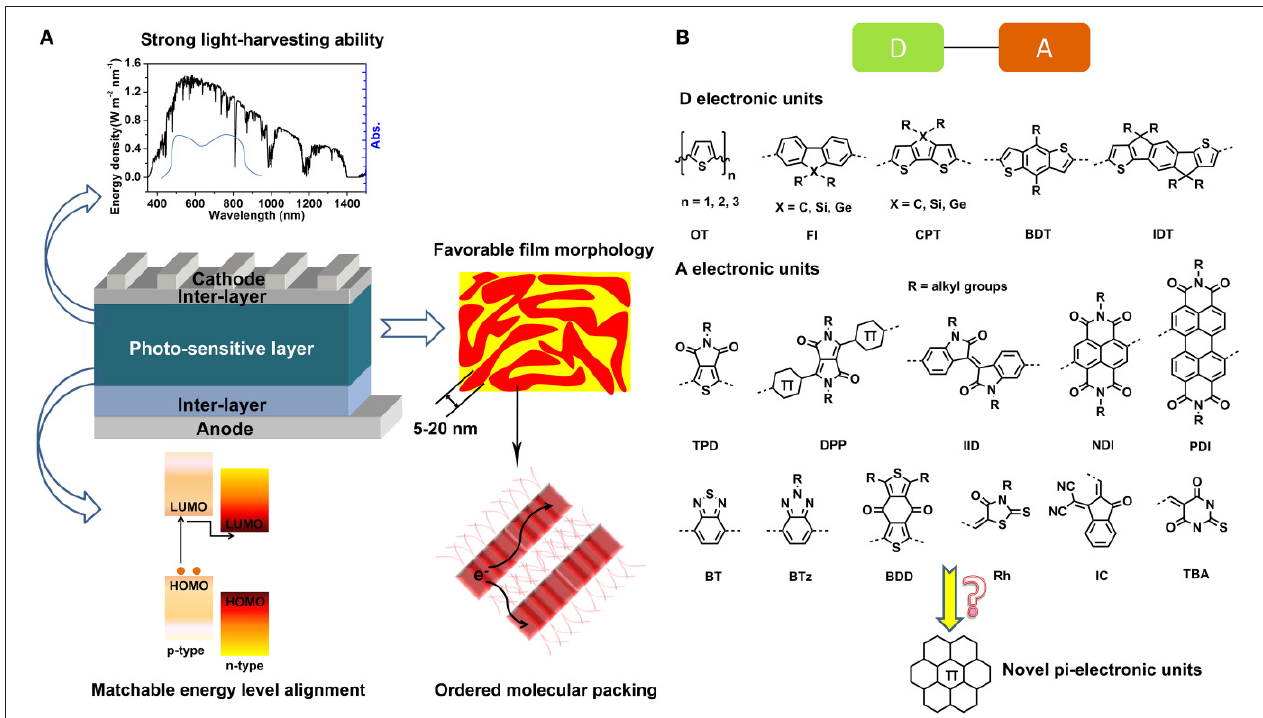
FIGURE 1 | Requirements for high-performance OPV devices (A) and representative D and A π -electronic units (B)